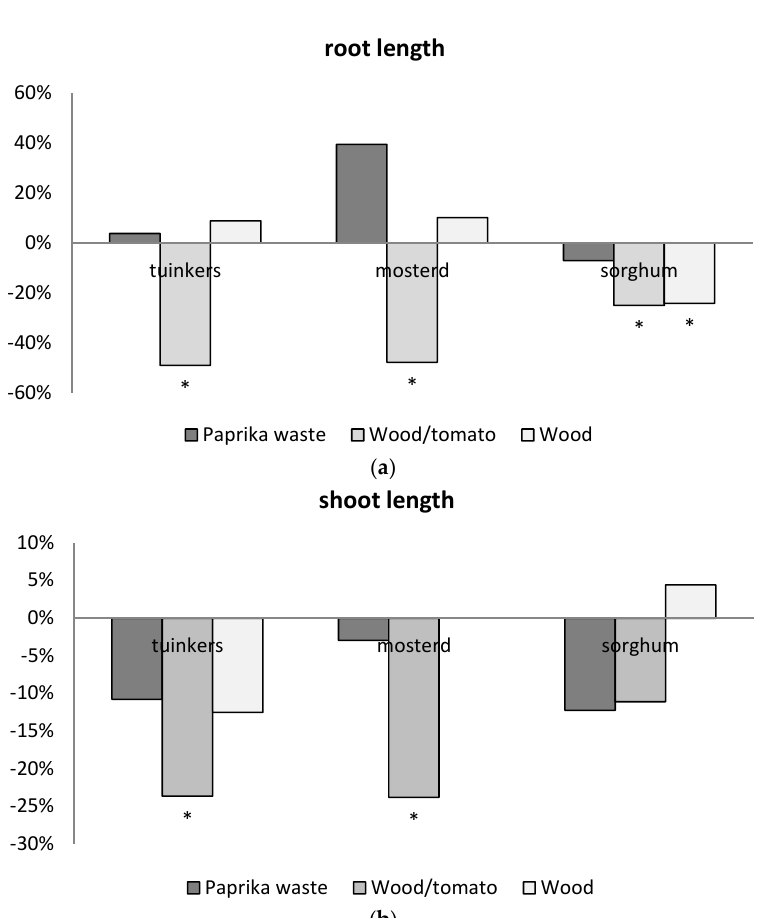
Figure 4. Average difference in root ( a ) and shoot length ( b ) between treatments and the control in the phytotoxicity test for three biochars produced from sweet pepper waste, wood and tomato leaves, and wood chips only. The asterisks denote a statistically significant reduction in root or shoot length at p = 0.05.